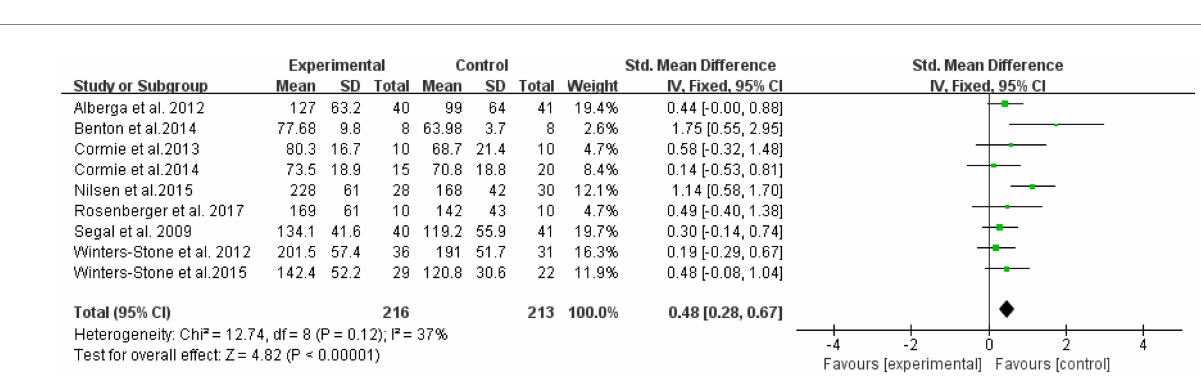
FIGURE 6 Resistance training on lower extremity strength in elderly cancer patients: